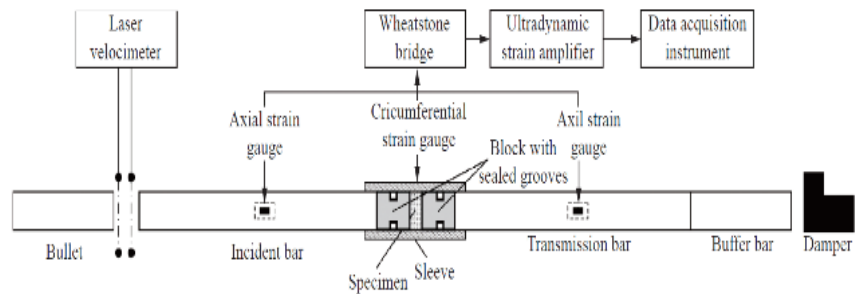
Figure 18. Schematic view of SHPB test stand (reprinted from Ref. [83]).